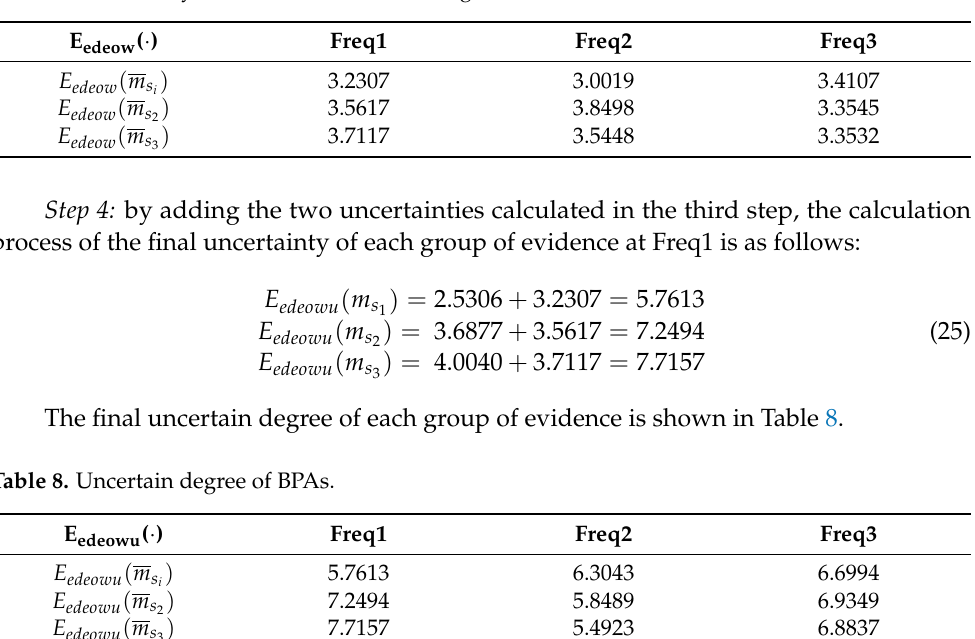
Table 7. Uncertainty measurement results of negation of BPAs based on EDEOW.